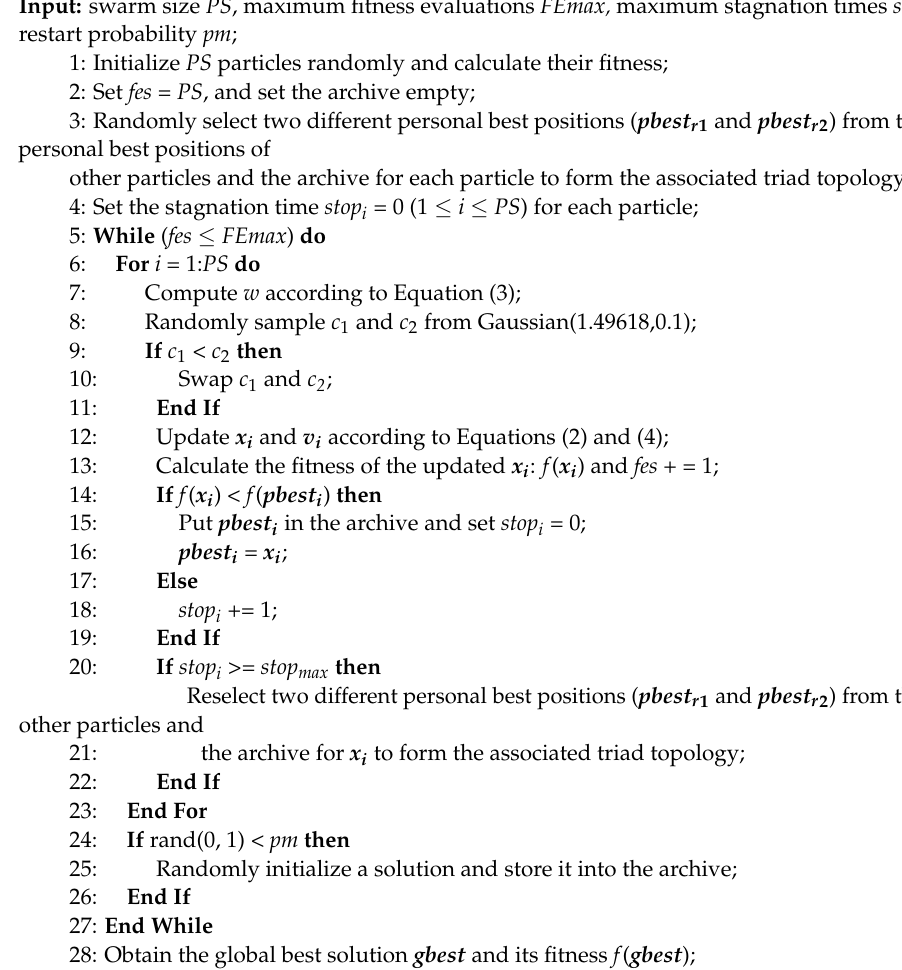
Algorithm 1: The pseudocode of